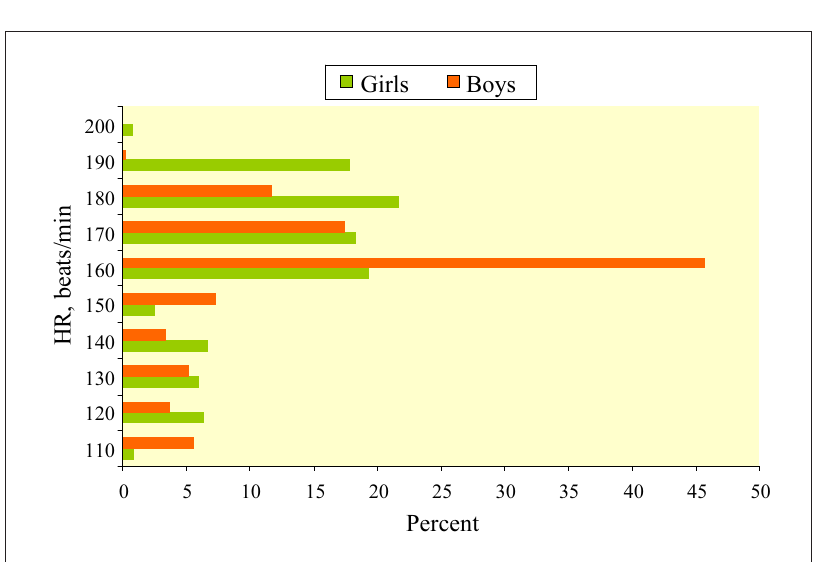
Figure 2. Energy outlay of juvenile sports dancers (kcal) during a 10-min Standard dance